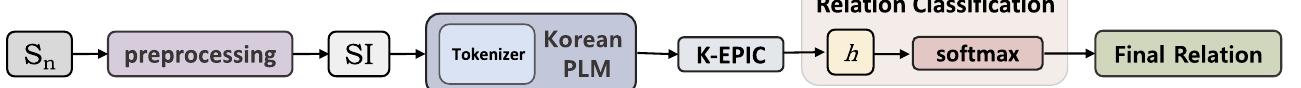
Figure 2. Overview of our K-EPIC process utilizing